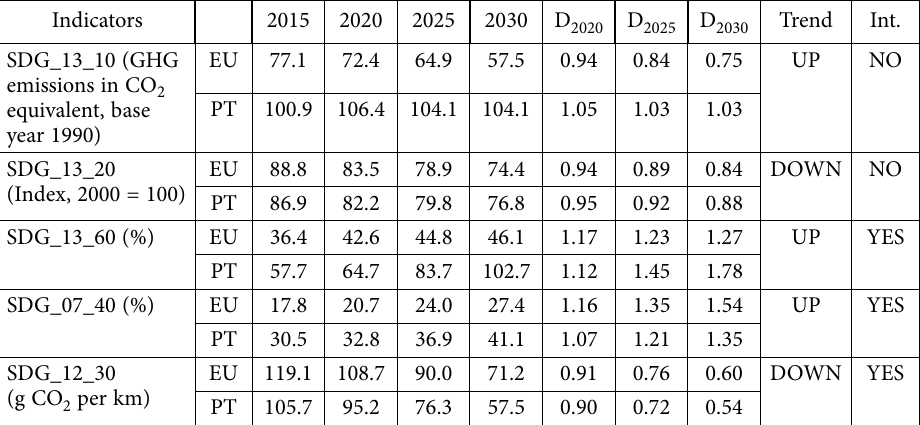
Table 14. SDG 13 – Climate action